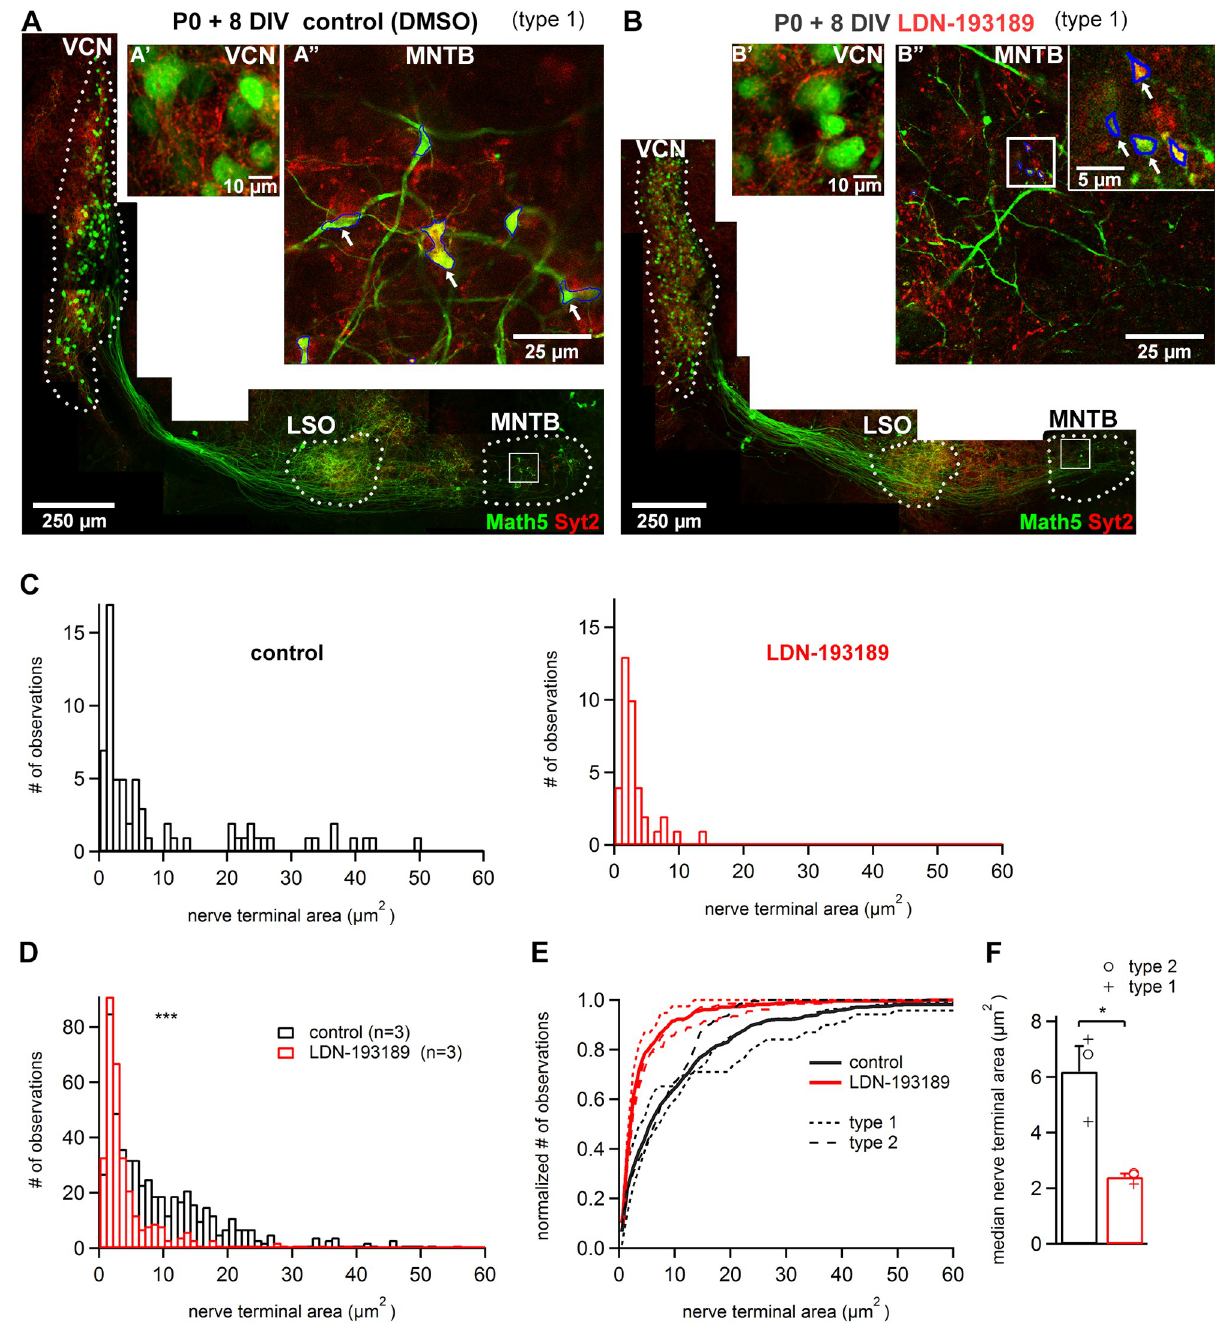
Fig 5. The BMP-SMAD inhibitor LDN-193189 reduces the size of calycesof Held developing in organotypic culture. A , B , examples of organotypiccultures preparedat P0 from two Math5 Cre x Brainbow littermate mouse pups. The slices were cultured in the presenceof DMSO alone( A ) or 5 μ M LDN-193189( B ), fixed after 8 days in-vitro , and stainedwith anti-GFP antibody, and anti-Syt2 antibody. A’ , B’ , high-magnification confocalimages on the level of the VCN. Note Math5- positive bushy cells visibleunder both conditions. A” , B” , confocal images on the level of the MNTB, in the areas indicatedby rectangles in A and B. Note the presenceof large, Syt2-positive nerve terminals under control conditions (A’’), but the conspicuousabsenceof large nerve terminals under LDN-193189 at the same magnification (B’’). The inset in B’’ is a highermagnification image of B’’. The blue lines in A’’ and B’’ are the nerve terminals outlinesat their widest extension. C , histograms of Syt2- and Math5- positive nerve terminalsize of the entire MNTB regionof the cultures shown in A and B (n = 68 and 38 nerve terminals for control, and for LDN-193189). D , histogramof nerve terminalsize from n = 3 organotypic cultures under each condition. Note the presenceof large nerve terminalsin the range of ~ 5–50 μ m 2 , which are largelymissing in slices cultured in the presenceof LDN- 193189. E , Same data as in D, shown as cumulative histograms for each culture. Short- versus long dashed lines show results from type 1—